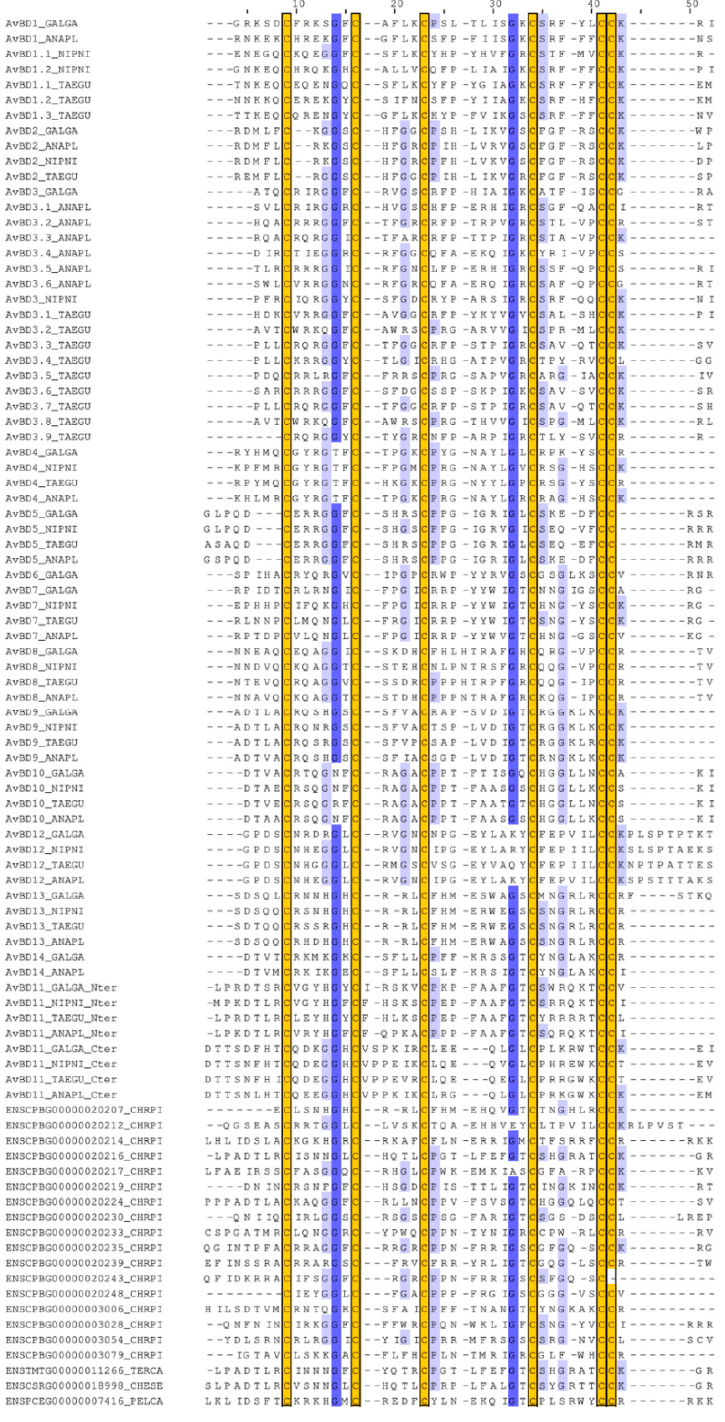
Figure 8. MSA of the N-terminal and C-terminal domains of AvBD11 with monodomain AvBDs and turtle β -defensins. MSA was performed with MAFFT and drawn with Jalview with a blue colour gradient (100% of identity for dark blue) and trimmed at each extremity to adjust to the length of